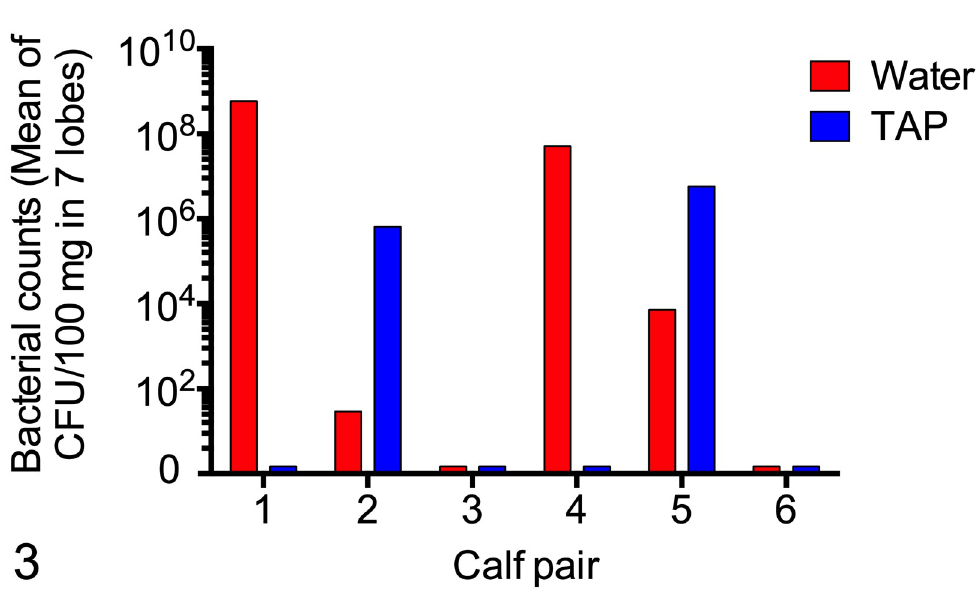
Fig 3. Isolation of Mannheimia haemolytica from the lungs. Six pairs of calves were challenged with M. haemolytica and treated with tracheal antimicrobial peptide (TAP) or water. At the end of the study, samples of right and left cranioventral, caudodorsal, and caudoventral areas of lung were analyzed by quantitative culture. The data show the mean bacterial counts among the 7 lobes tested for each calf.